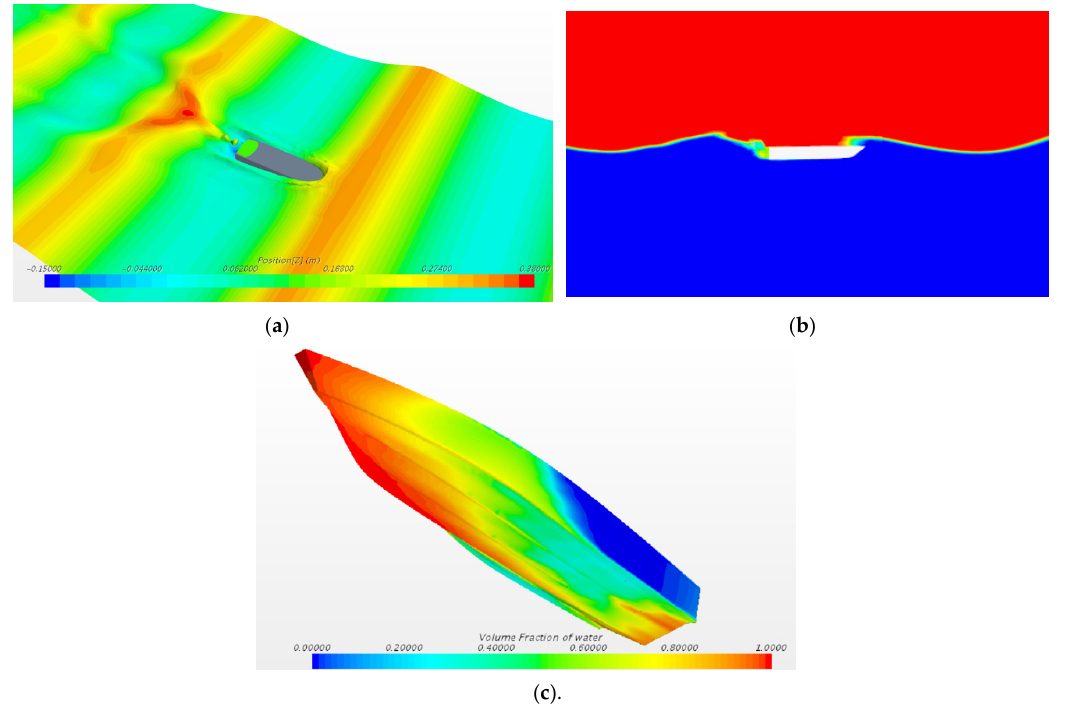
Figure 17. The simulation of the sailing of the improved vessel in the wave ‐ piercing status: ( a ) Free surface; ( b ) Gas–liquid phase diagram; ( c ) Free surface representation of the hull.